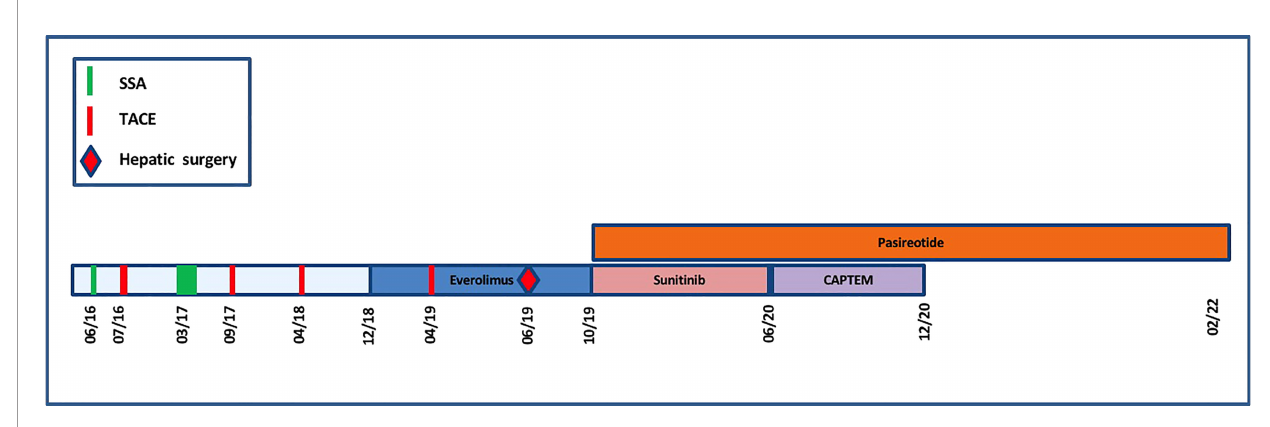
FIGURE 5 | Timeline representing the anti-proliferative and anti-secretory treatments